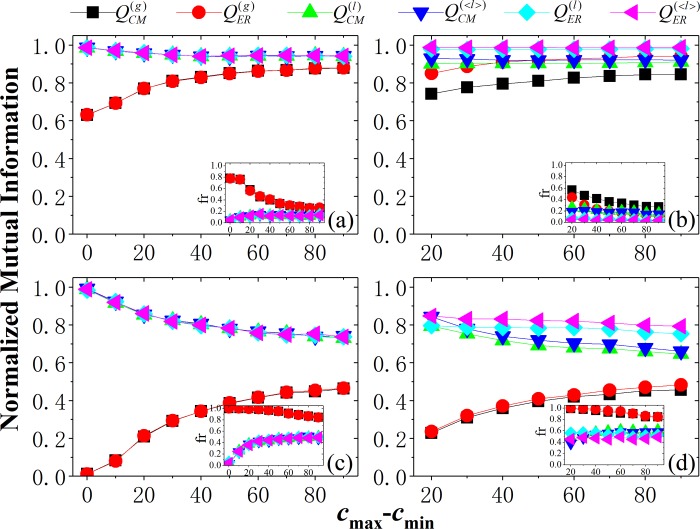
Normalized mutual information (NMI) obtained by different modularity as a function of community-size difference (cmin-cmax) in the NET1 networks.Parameters of networks: (a) N=1000, kmax=10; (b) N=1000, kmax=30; (c) N=5000, kmax=10; (d) N=5000, kmax=30 (see Table 1 for details of network parameters). Inset graphs show the fraction (fr) of affected nodes due to the merging of communities (i.e., the first-type resolution limit) by different methods as a function of community-size difference in the networks.